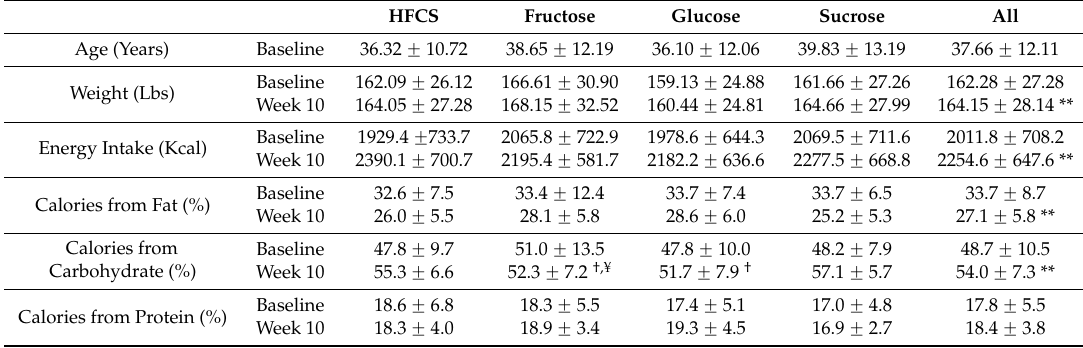
Table 1. Changes in weight and dietary intake during ten weeks of daily consumption on each of 4 different types of